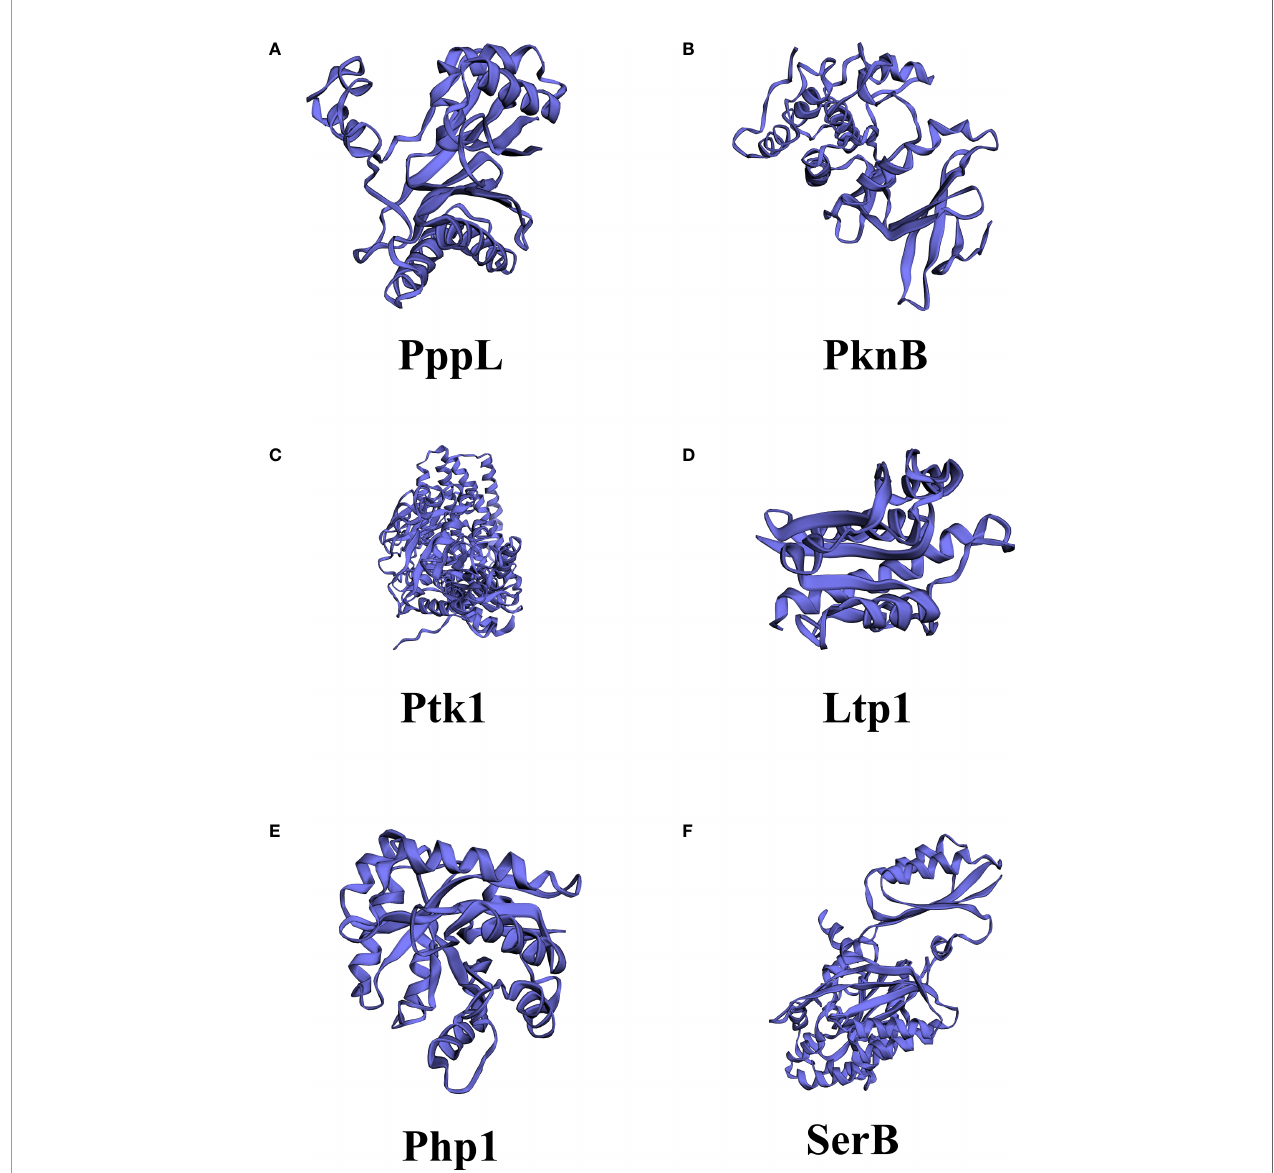
FIGURE 2 | Different structures among kinases and phosphatase in Streptococcus mutants and Porphyromonas gingivalis . (A) PppL , S. mutants PPM family protein phosphatase; (B) PknB , S. mutants serine/threonine protein kinase; (C) Ptk1, P. gingivalis tyrosine kinase; (D) Ltp1 , P. gingivalis low molecular weight protein- tyrosine phosphatase; (E) Php1 , P. gingivalis PHP family tyrosine phosphatase (F) SerB , P. gingivalis Serine/threonine protein phosphatase. The structures were predicted by PHYRE2 Protein Fold Recognition